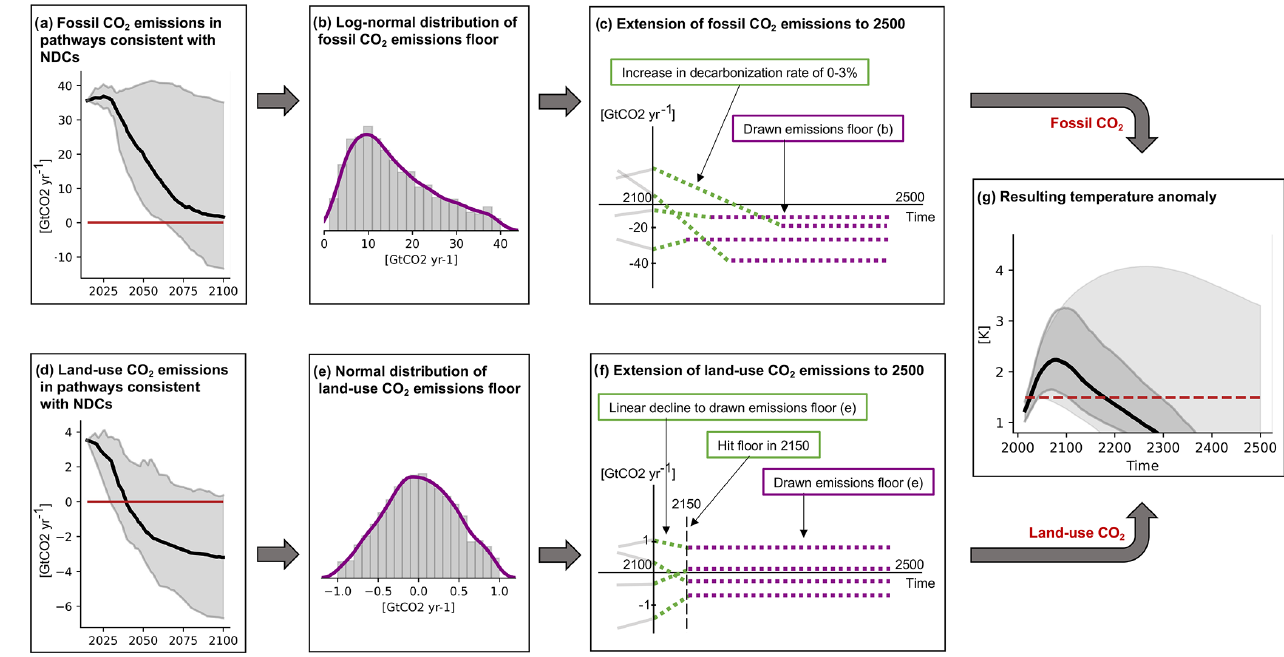
Figure 1. Extension of emission pathways consistent with NDCs from the AR6 WG3 database to 2500. A distribution of extension options is used to sample the range of possible outcomes consistent with the current literature. For simplicity, in all cases, non-CO 2 emissions are kept constant after 2100. (a) Fossil CO 2 emissions from selected IPCC AR6 WG3 database scenarios (displayed: 5th–95th percentile). (b) Distribution of minimum fossil CO 2 emissions used in this study. (c) Illustration of extension algorithm used for fossil CO 2 emissions – each pathway is extended at a fixed rate of decline until it hits some prescribed value, after which emissions are held constant (see Sect. 2.1 for full description). (d) Land use CO 2 emissions from selected IPCC AR6 WG3 database scenarios (displayed: 5th–95th percentile). (e) Distribution of steady-state land use CO 2 emissions used in this study. (f) Illustration of extension algorithm used for land use CO 2 emissions – each pathway is extended so that it reaches a specific value by 2150, after which emissions are held constant (see Sect. 2.1 for full description). (g) Resulting temperature trajectories – the light-grey shading covers the 5th–95th percentiles over all scenarios with all 600 ensemble members, and the dark-grey shading covers the 5th–95th percentile of an exemplary scenario (MESSAGEix-GLOBIOM_1.1 EN_INDCi2030_1800f_NDCp), with the black line being the median of it. We cover a wide range of trajectories, from always remaining below 1.5 ◦ C to never coming back below 1.5 ◦ C after crossing 1.5 ◦ C in the early 21st